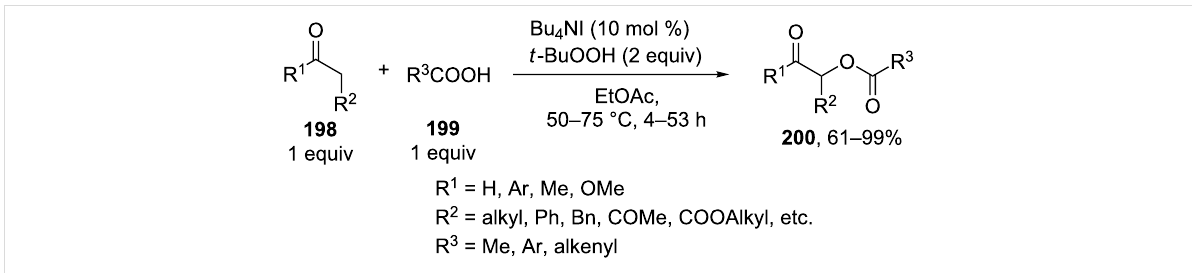
R 1 = Ar, alkyl R 2 = H, alkyl,